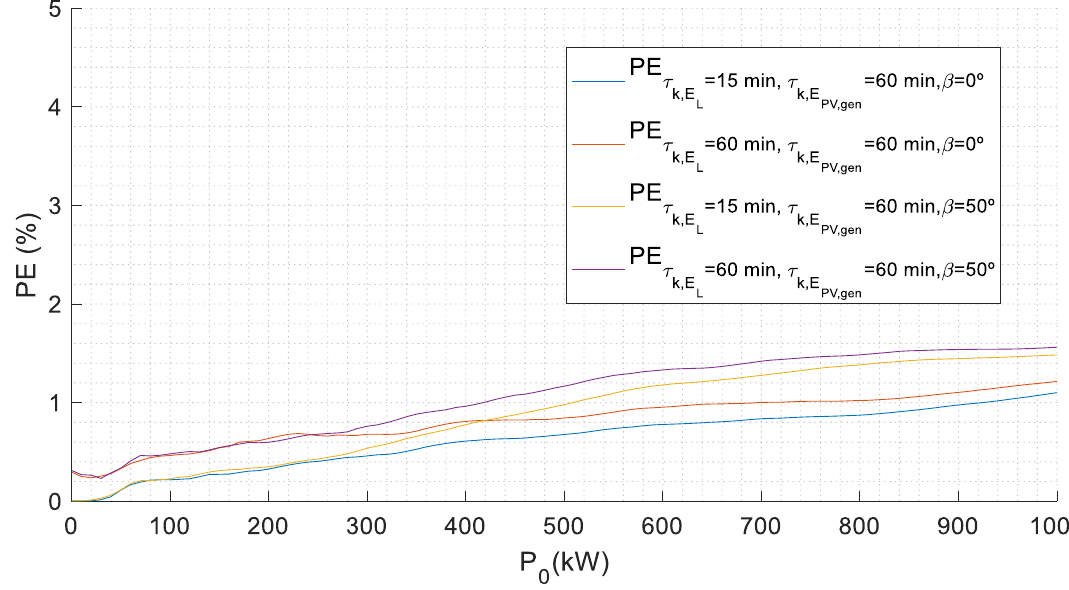
Figure 3. Annual self-consumed photovoltaic energy error as a function of P 0 considering a recording interval of 60 min. Recording interval of 15 min either for E PV,gen and E L has been taken as a reference when E PV,con is estimated.